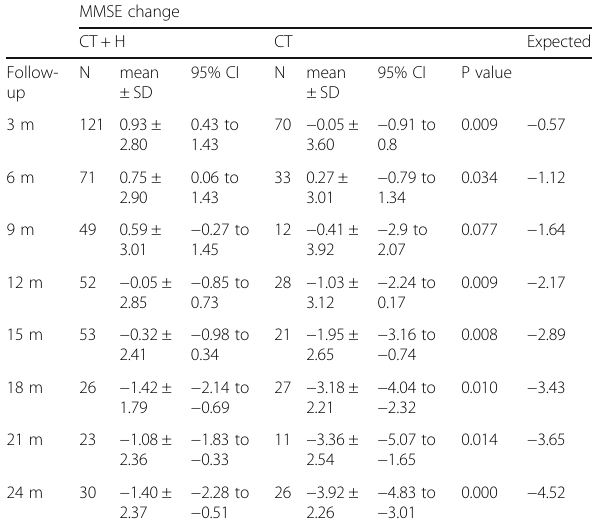
Table 2 MMSE change between groups with or without herbal